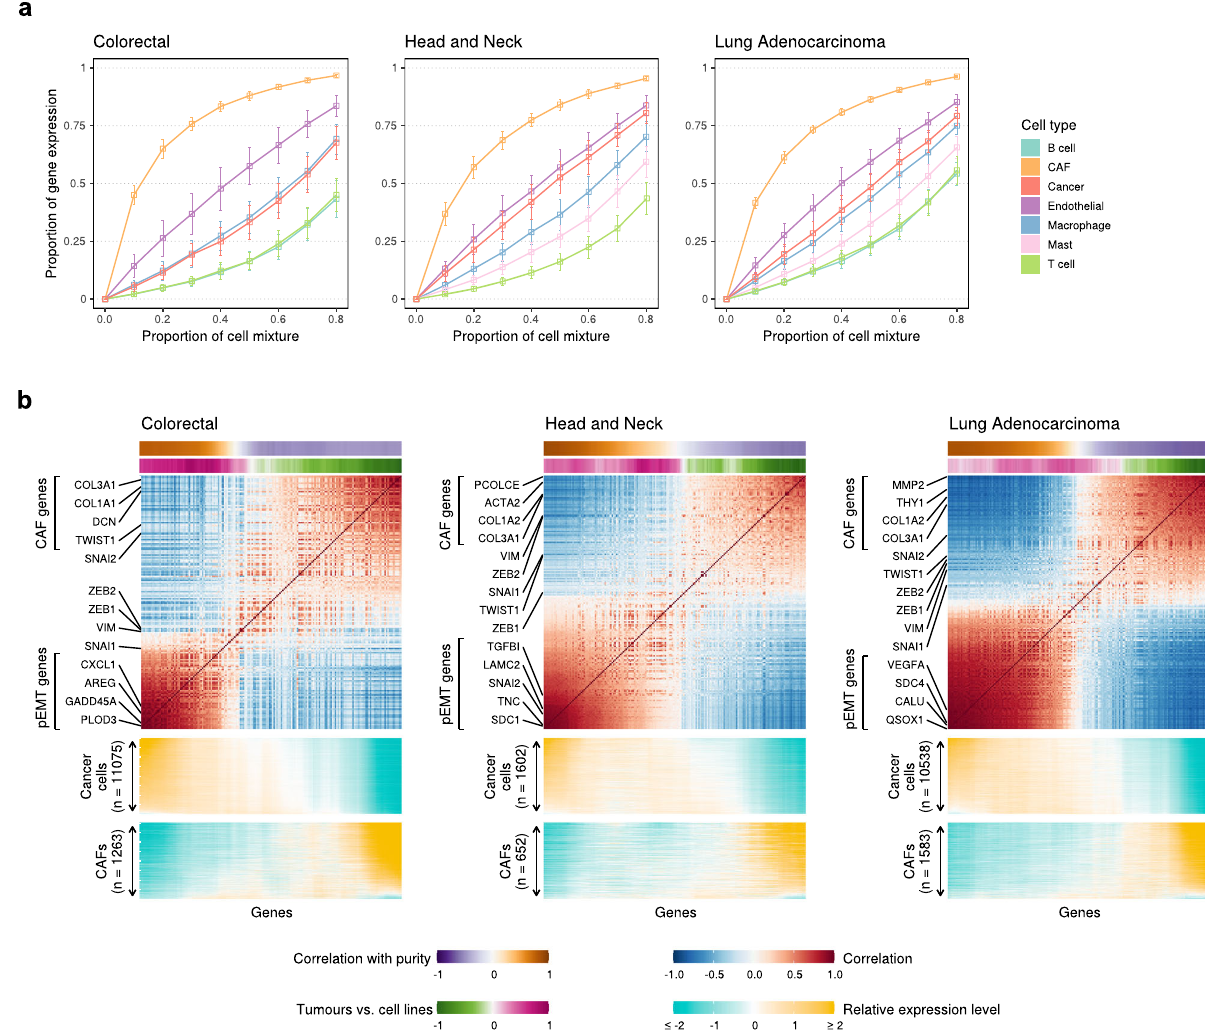
Fig. 2 Contribution of different cell types to expression of ESGs in simulated bulk tumours. a Line plots showing the relative contributions of different cell types to ESG expression (EMT signal), for various fractions of tumour composition, in simulated bulk expression pro fi les based on 3 scRNA-seq datasets out of the 8 considered (the remaining 5 are shown in Fig. S8a). Each point represents the average proportion of EMT signature gene expression coming from the corresponding cell type in a collection of 100 simulated tumours with the given fraction of that cell type and varying proportions of the other cell types. Error bars show the standard deviation over the set of 100 simulations. b ESG co-expression matrices derived from simulated bulk expression pro fi les based on the 3 scRNA-seq datasets shown in ( a ) (the remaining 5 are shown in Fig. S8b), ordered by the SPIN side-to-side algorithm 37 with slight modi fi cations (see Methods). ESGs are annotated with two colour-coded panels at the top: (1) correlations with simulated tumour purity (Pearson correlation coef fi cient); and (2) comparison of expression levels in simulated tumours versus in cell lines, where positive numbers indicate higher expression in tumours than in cell lines. Heatmaps below the co-expression matrices show the relative expression levels of ESGs in individual CAFs (bottom rows) and cancer cells (top rows) in the scRNA-seq data. Selected ESGs are labelled at the side of each co-expression matrix. Source data are provided as a Source Data fi